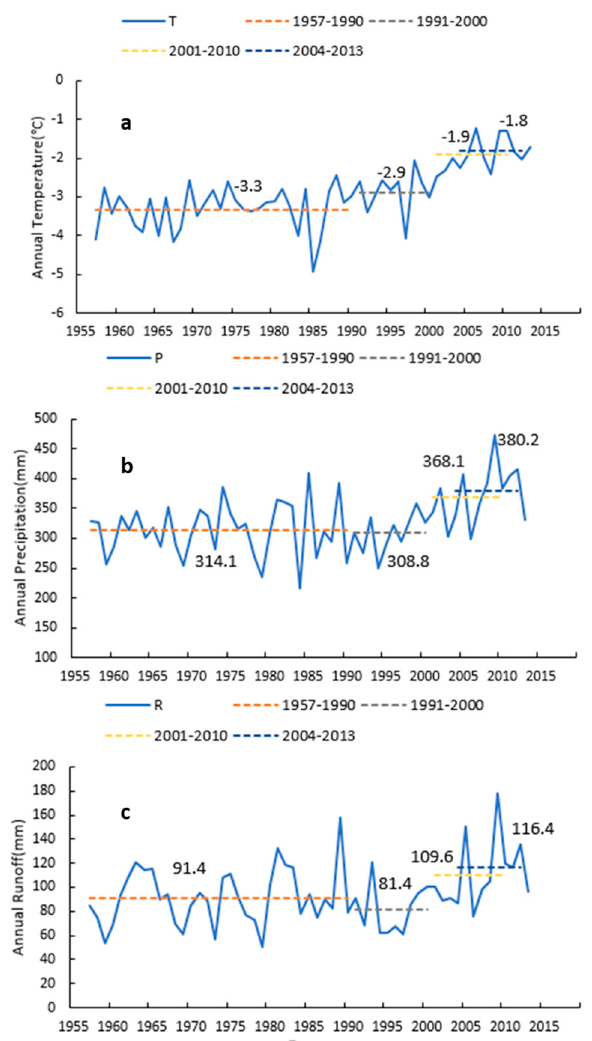
Figure 3. Annual time series and decadal average values for investigated hydro ‐ climatic variables in the SRYR (1957–2013); ( a ) mean annual temperature in °C; ( b ) mean annual precipitation in mm; ( c ) mean annual runoff in mm. Four periods for decadal average: 1957–1990; 1991–2000; 2001–2010; 2004– 2013 during the latest 10 years.